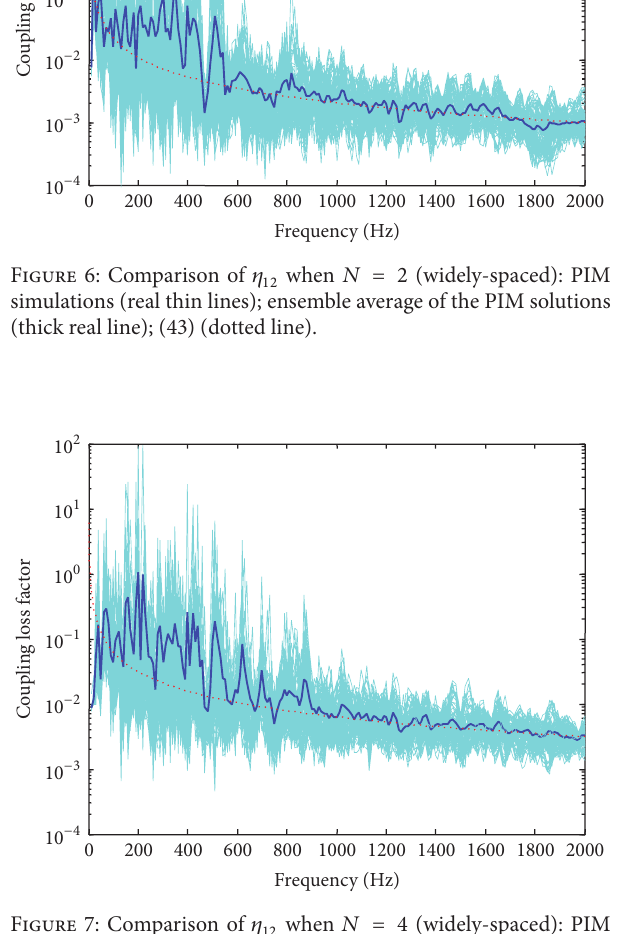
Figure 7: Comparison of 𝜂 12 when 𝑁 = 4 (widely-spaced): PIM simulations (real thin lines); ensemble average of the PIM solutions (thick real line); (43) (dotted line).